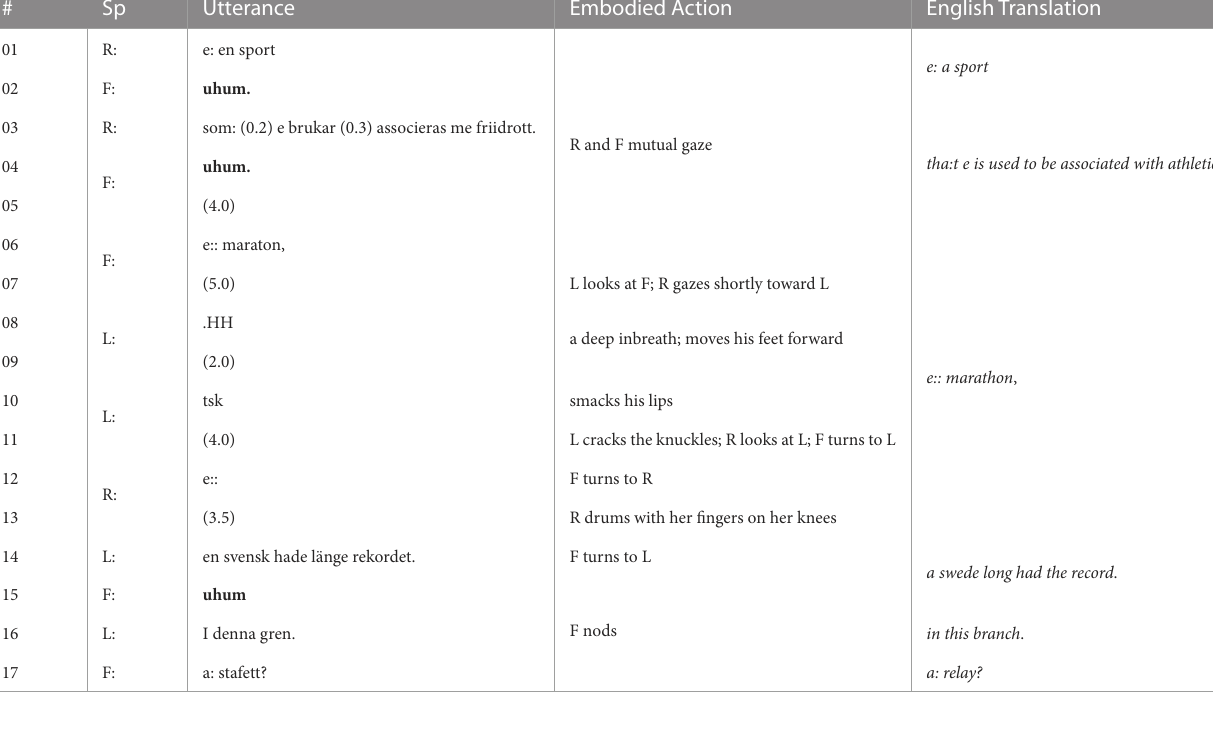
TABLE3 Transcriptexcerptfromanon-collaborativeinteraction.Sp=Speaker(Left,Right,Furhat).Robotbackchannelshighlightedinbold.